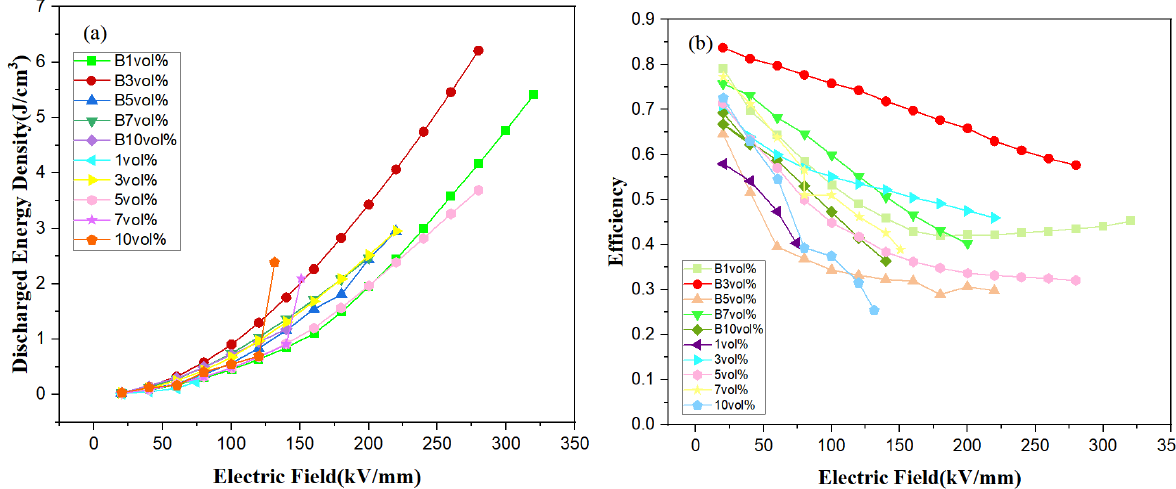
Figure 9. Discharge energy density ( a ) and efficiency ( b ) for 7FO/PVDF nanocomposite films with different doping